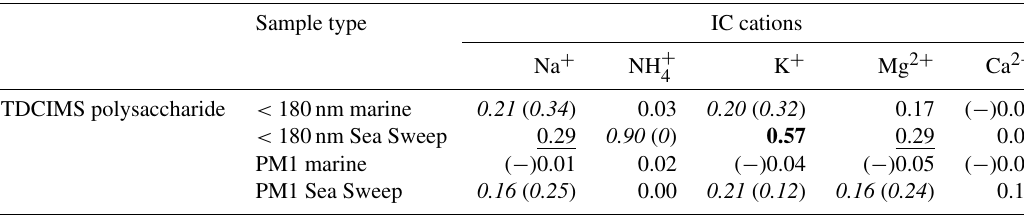
Table 3. Coefficients of determination ( r 2 s) for relationships between polysaccharide mass and inorganic cation mass, for sub-180nm and submicron samples of ambient marine and Sea Sweep aerosol. Bold text indicates a strong statistical relationship, with a linear slope 4 standard deviations greater than 0. Underlined text indicates a modest relationship, with a linear slope 2 standard deviations greater than 0. Cases for which removing a single point changes a relationship between none and modest or none and strong are shown as “with (without)” that point and italicized. Relationships for which r is negative are indicated with ( −